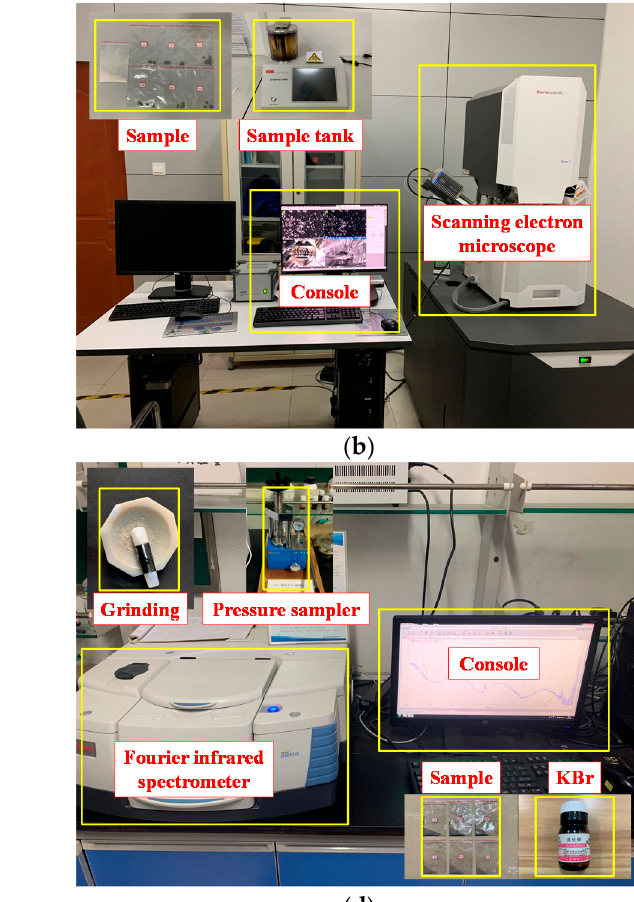
Table 2. Uniaxial test results of CGFB samples.